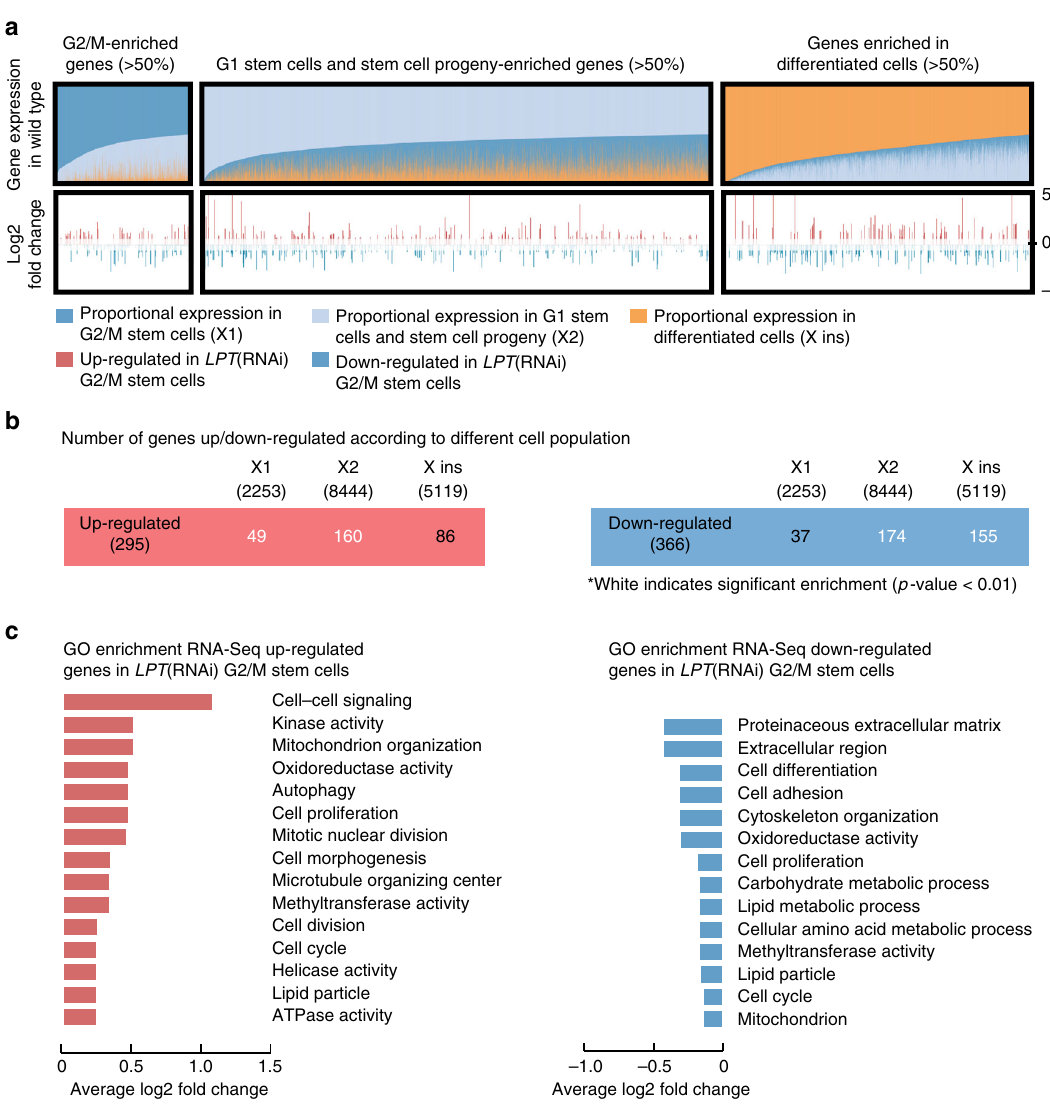
Fig. 7 RNA-seq of G2/M stem cells following LPT (RNAi) reveals effects on genes enriched in different cell populations. a Genes were classi fi ed according to their proportional expression in the X1 (G2/M stem cells; dark blue), X2 (G1 stem cells and stem cell progeny; light blue) and X ins (differentiated cells; orange) FACS populations of cells. Genes were de fi ned as enriched in certain population(s) if >50% of their expression is observed in that population in wild type animals. Each vertical line represents a gene. Under the population expression enrichment track is a track with all the signi fi cantly up- and down- regulated genes in G2/M stem cells following LPT (RNAi). The genes with fold change >1.5 ( p < 0.05) are shown in red following a log2 fold change transformation. The genes with fold change < − 1.5 ( p < 0.05) are shown in blue following a log2 fold change transformation. The Wald ’ s test (as part of the Sleuth software) was used for assessing differential expression. b Enrichment for genes in each of the three classes was calculated for the up- and down- regulated genes ’ list (red and blue respectively). The number of genes in each group is indicated in brackets under the group ’ s name. Numbers in white represent signi fi cant enrichment ( p < 0.01) according to a hypergeometric enrichment test. c Gene Ontology (GO) enrichment analysis on the genes signi fi cantly up-regulated (red) and down-regulated (blue) in G2/M stem cells following LPT (RNAi). Categories are sorted by average Log2 fold change of the up- or down-regulated genes falling in each category. In bold are shown terms that relate to the described Mll3/4 loss of function